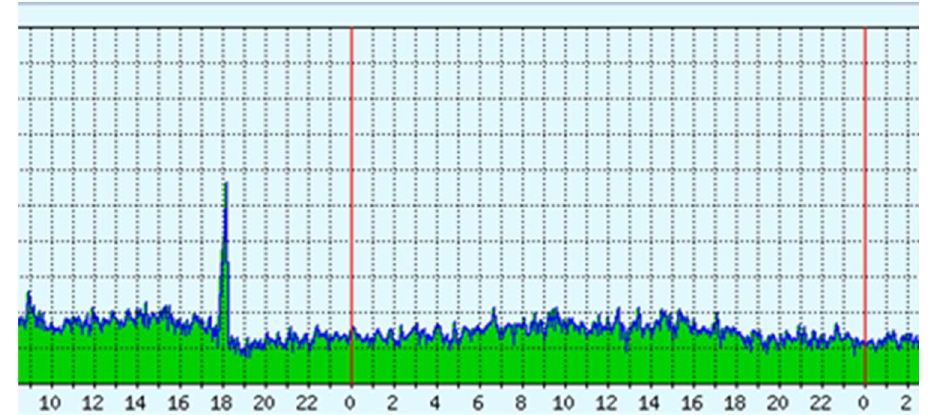
Figure 9. DDoS traffic live detection.